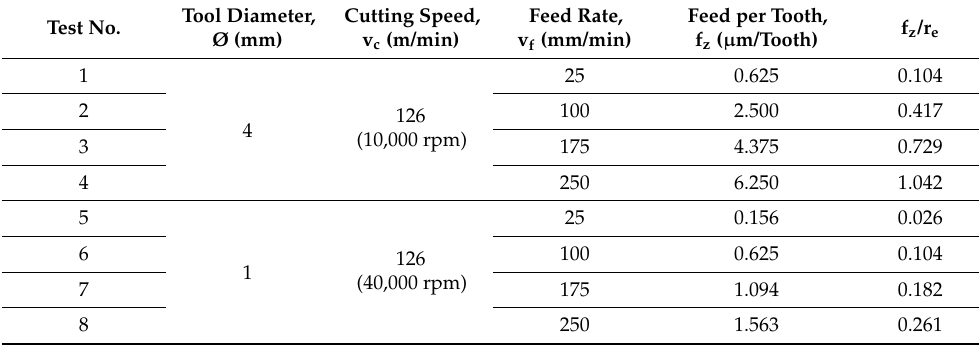
Table 2. Test parameters and